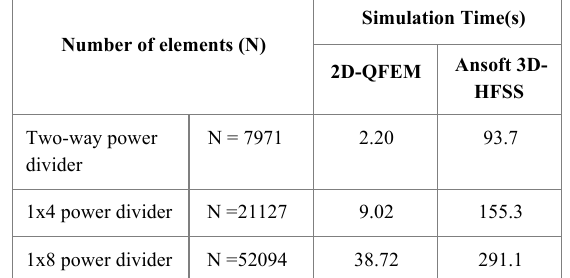
TABLE 2. Comparison of the simulation time with QFEM and Ansoft